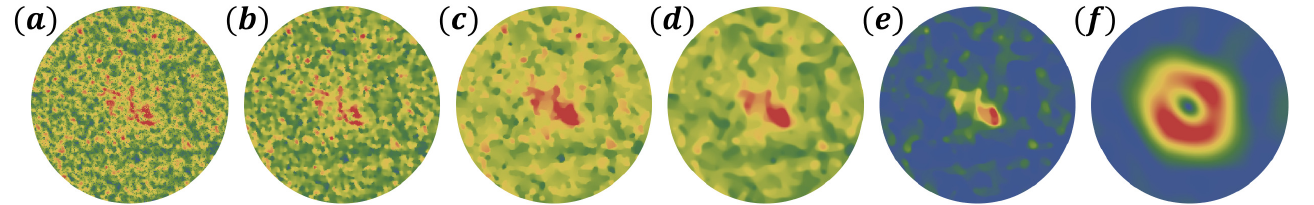
Figure 7. Effects of global filtering (Algorithm 3) on the luminance map of the neighborhood of the lowermost bubble in Figure 7 indicated by a white dashed circle: ( a ) neighborhood projection of the original pre-processed image; ( b ) PM-filtered; ( c ) Poisson TV-filtered; ( d ) SSCF-filtered; ( e ) SCTMM output; ( f ) gradient filter output (edge